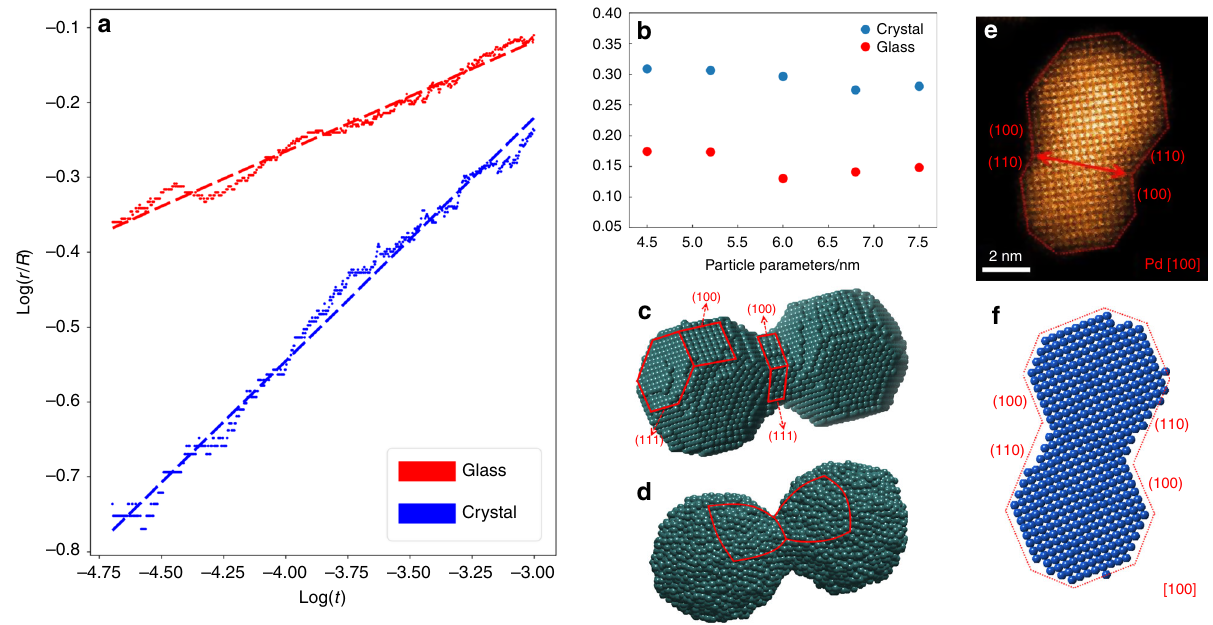
Fig. 4 KMC simulations on the coalescence of crystalline and amorphous particle pairs. a KMC simulations on the evolution of neck diameters as a function of time in logarithm, at the simulation temperature of 400 K. b Coalescence slopes as a function of particle sizes. c Snapshots of a crystalline particle pair during coalescence in KMC simulation. The faceting takes place during the coalescence of the crystalline particles and due to the slow kinetics with a smaller exponential of ~3. d KMC snapshot of an amorphous particle pair during coalescence. Isotropic surface structure remains during the coalescence. e High resolution HAADF-STEM image of a faceted FCC particle pair at 738 K. f KMC snapshot of a FCC particle pair during coalescence, which